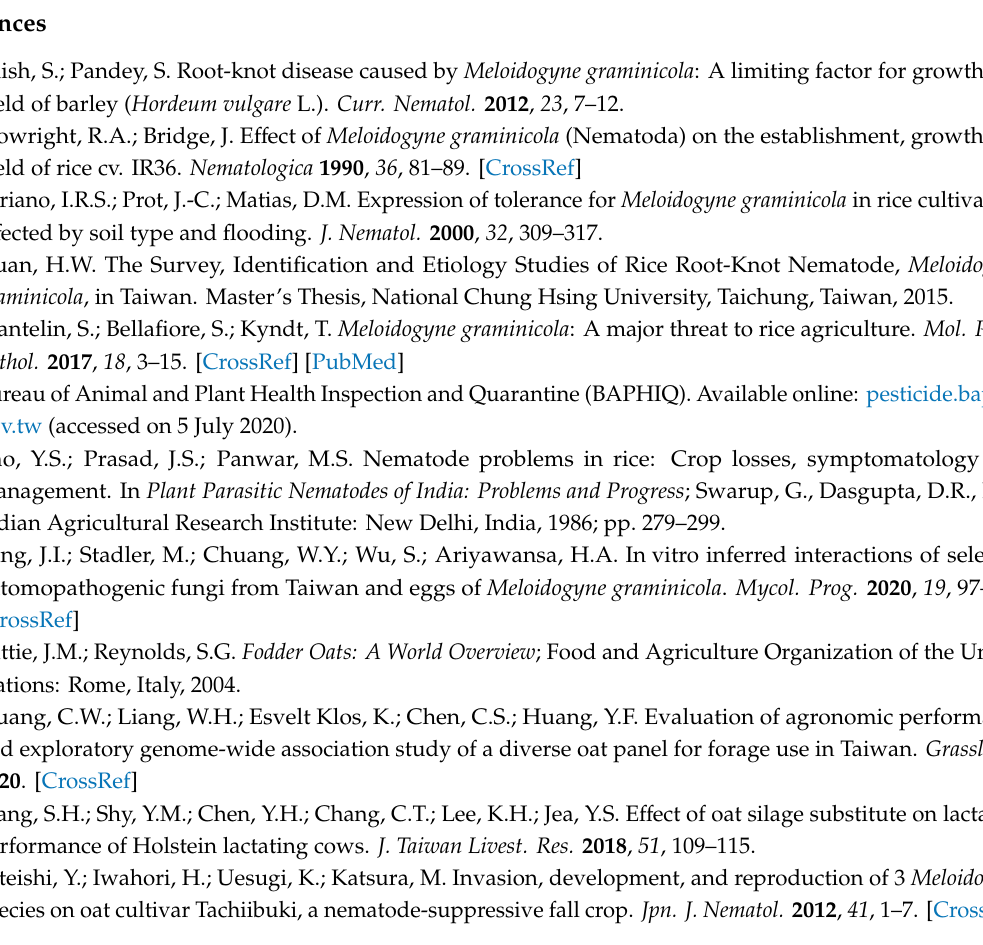
Table S1: The pedigree of oat breeding lines used in this